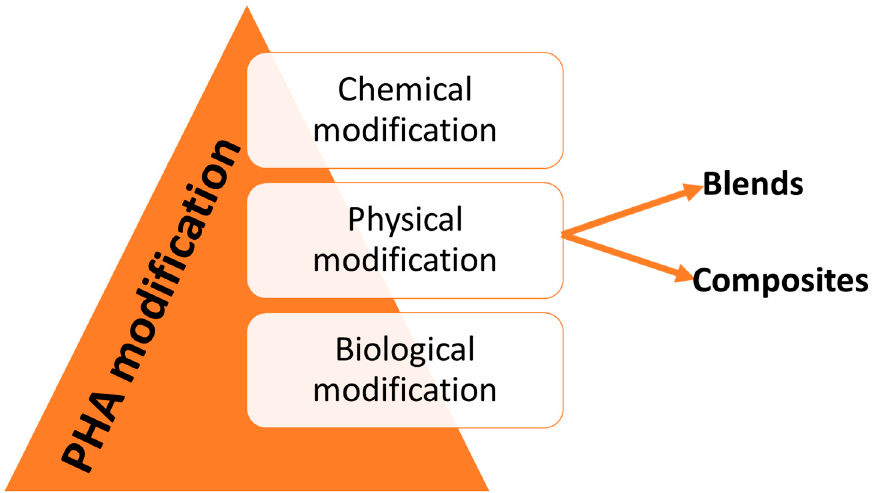
Figure 6. Different modifications of PHA.